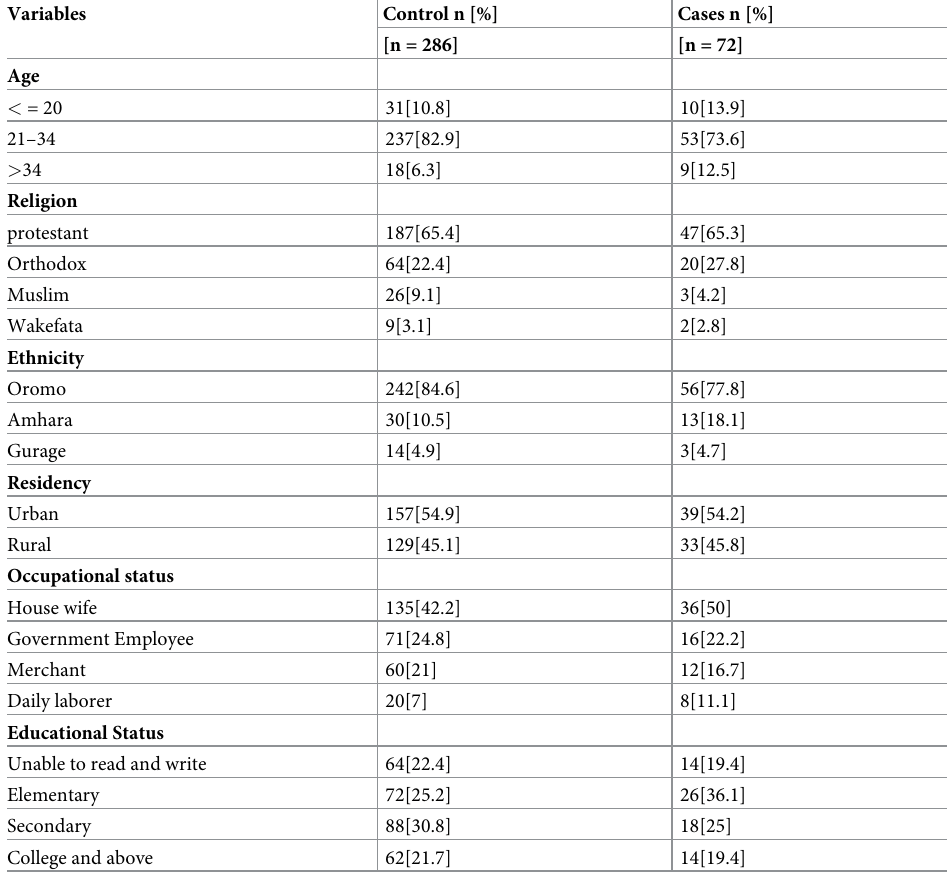
Table 1. Sociodemographic characteristics of cases (n = 72) and controls (n = 286) in selected hospitals of Wollega zones,